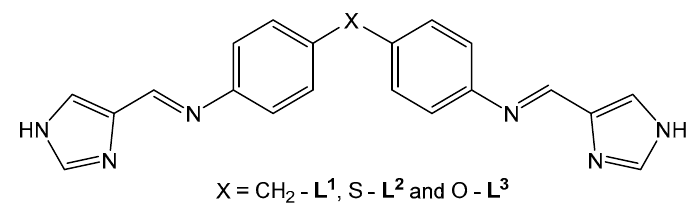
Figure 1. Schematic representation of the ligands L 1 , L 2 and L 3 .